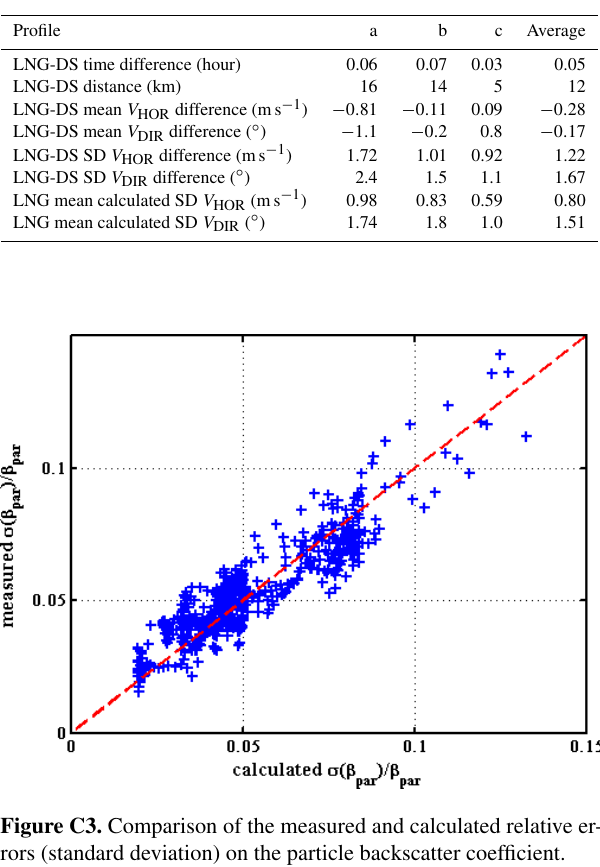
ences remain small.